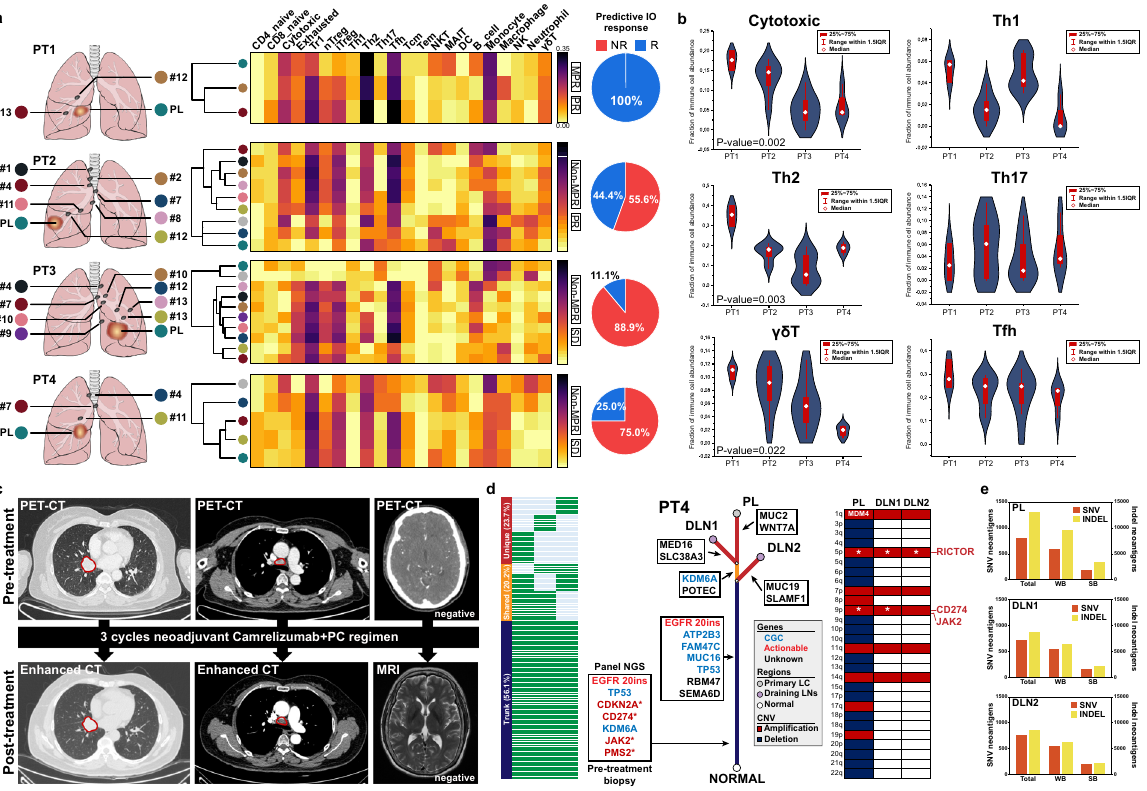
Fig. 3 Overview of in fi ltrating immune contexture and genomic pro fi le of resected PL and DLNs after neoadjuvant immunotherapy. a Non-supervised clustering of in fi ltrating immune microenviornment among PL and DLNs through ImmuCellAI. Pie chart indicates the proportion of samples which are antipated as responsive to immunotherapy. R Responder, NR Non-responder. b Comparison of speci fi c immune cell subtypes among different patients. Kruskal-Wallis test was used to testify the difference among patients. Centre dots represent the median value of speci fi c immune cell in fi ltration. Error bars represent the upper and lower quartiles and whiskers de fi nes the range within 1.5IQR. c Radiological evaluation before and after neoadjuvant immunotherapy for PT4. d Genomic evolutionary trajectory between PL and DLNs of PT4. e Indel- and SNV-induced neoantigens burden among PL and DLNs through